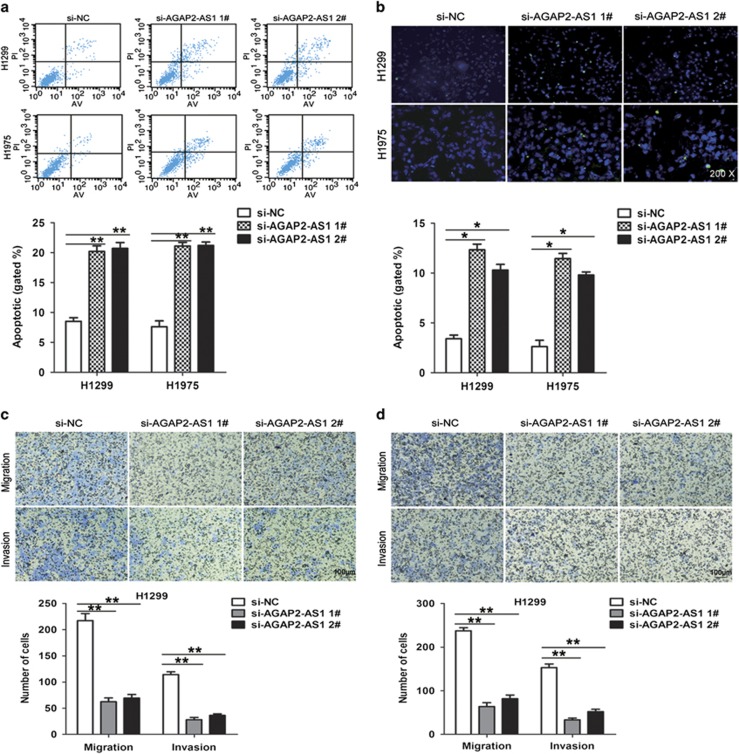
Knockdown of AGAP2-AS1 induced NSCLC cell apoptosis and inhibited cell migration and invasion in vitro. (a) Flow cytometry assays were performed to analyze the cell apoptosis in si-AGAP2-AS1-transfected H1299 and H1975 cells. LL, dead cells; UL, viable cells; LR, early apoptotic cells; UR, terminal apoptotic cells. (b) Tunel staining assays were performed to analyze the cell apoptosis when AGAP2-AS1 was knocked down. Green, apoptotic cell; blue, DAPI staining for nuclear. (c and d) Transwell assays were used to determine the effect of knockdown of AGAP2-AS1 on cell migration and invasion. The cells on the lower chamber were stained and presented, and cell number in random six perspective was calculated. All experiments were performed in biological triplicates with three technical replicates and data represented the mean±S.E.M. *P<0.05, **P<0.01